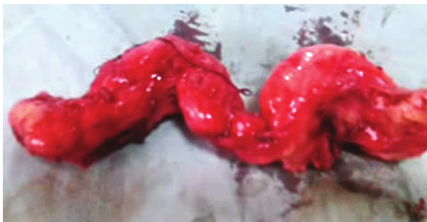
Figure 6: Excised specimen of esophageal leiomyoma immediately after operation.